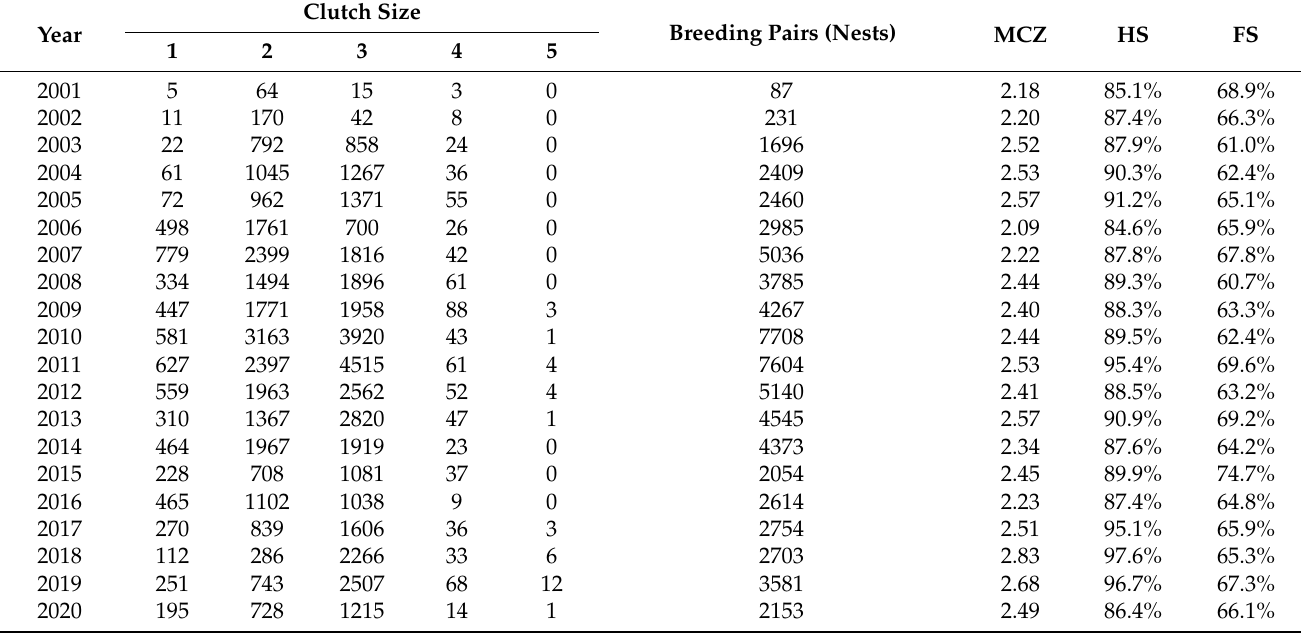
Table 1. Numbers of breeding pairs, clutch size, reproductive success of Relict gull in Hongjian Nur, Shaanxi Province from